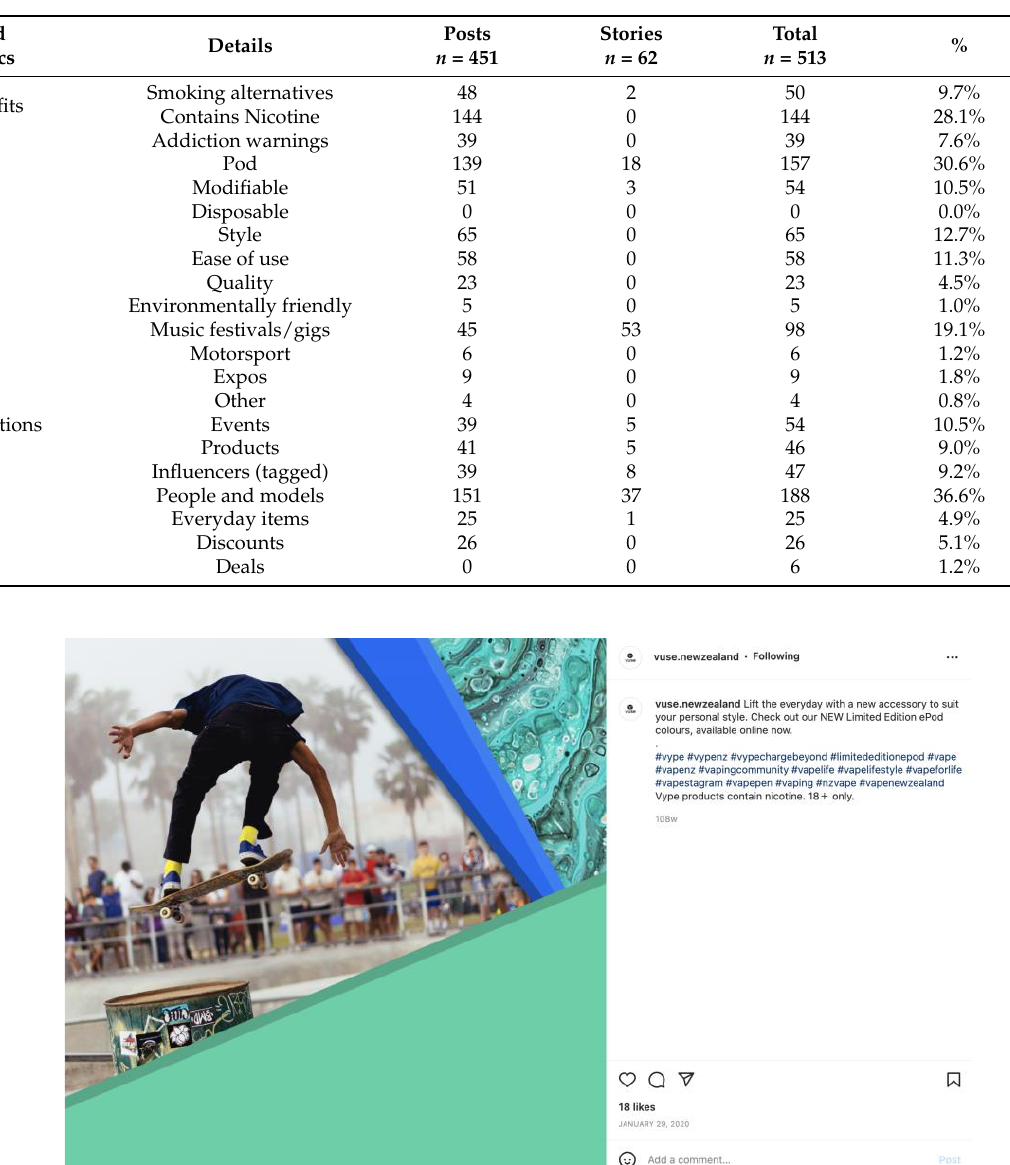
Table 2. Characteristics of Instagram posts of New Zealand e-cigarette retailers.